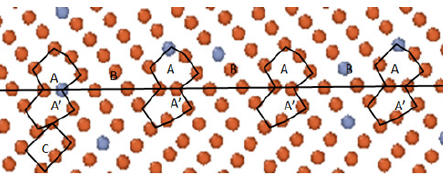
Figure 9. Structure of the Σ17(223) GB in the Fe-9 at.% Cr alloy. Red circles represent Fe atoms and light gray circles represent Cr atoms.